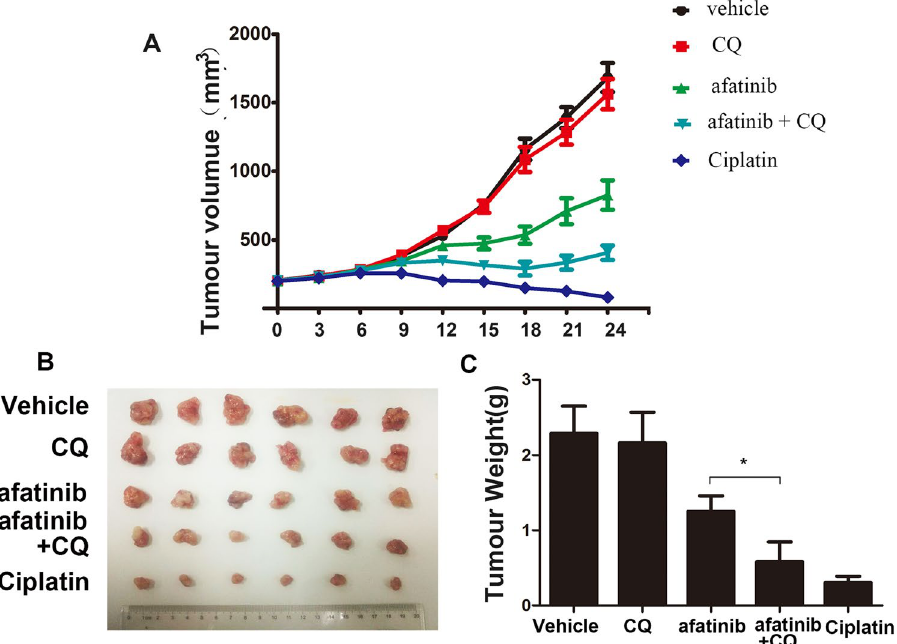
Figure 8. Suppression of autophagy improves the antitumor effect in lung adenocarcinoma xenograft model. ( A ) Athymic nude mice bearing isogenic H1975 xenograft tumors were treated with vehicle, afatinib, CQ, afatinib in combination with CQ and the cisplatin. Tumor growth was measured as described in Materials and Methods. The growth curves represent the average values of 6 mice in each group. Error bars indicate standard deviation. ( B ) The picture of different tumor groups. ( C ) The tumor weight of different groups. All data were presented as mean ± SD ( * P <